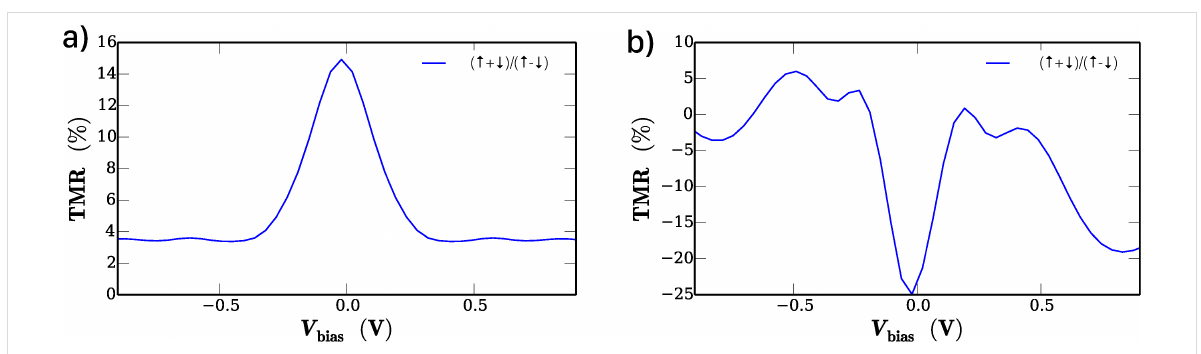
Figure 4: Calculated TMR for the sandwich structure a) CoPc/CoPc and b) F 16 CoPc/MnPc on Ni(111). The TMR as a function of the bias voltage is obtained from the spin-polarized current within the DFT-NEGF